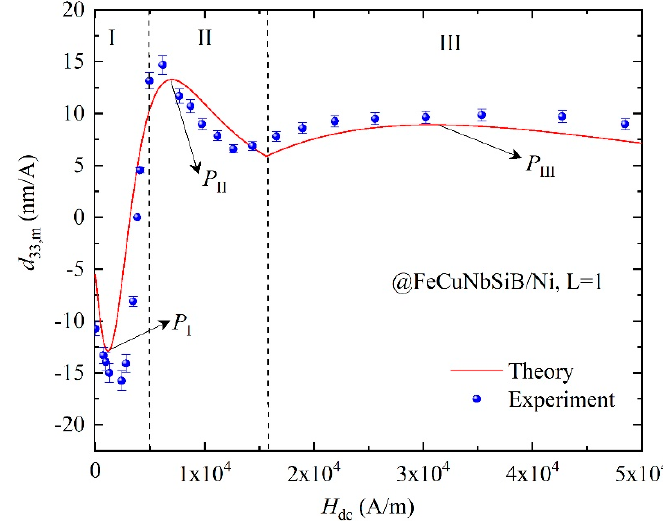
Figure 6. The calculated and experimental d 33 ,m as a function of H dc for the FeCuNbSiB/Ni laminate. The layer of FeCuNbSiB is one ( L = 1).